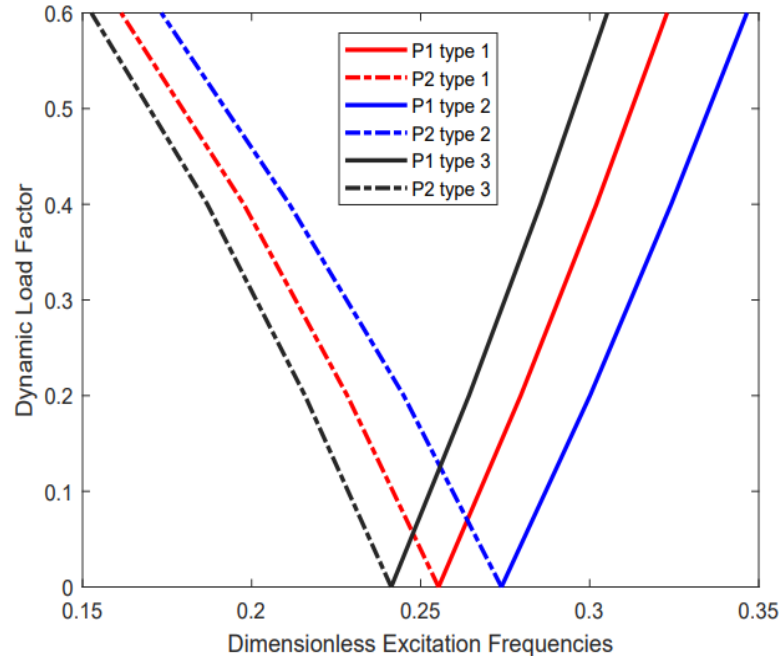
Figure 3. The effect of porosity distribution.